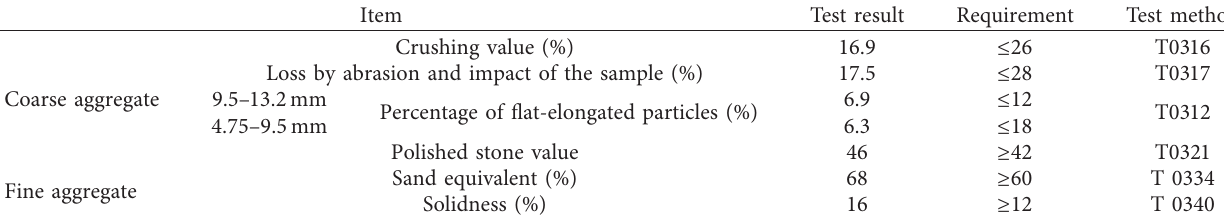
Table 2: Properties of the aggregates.